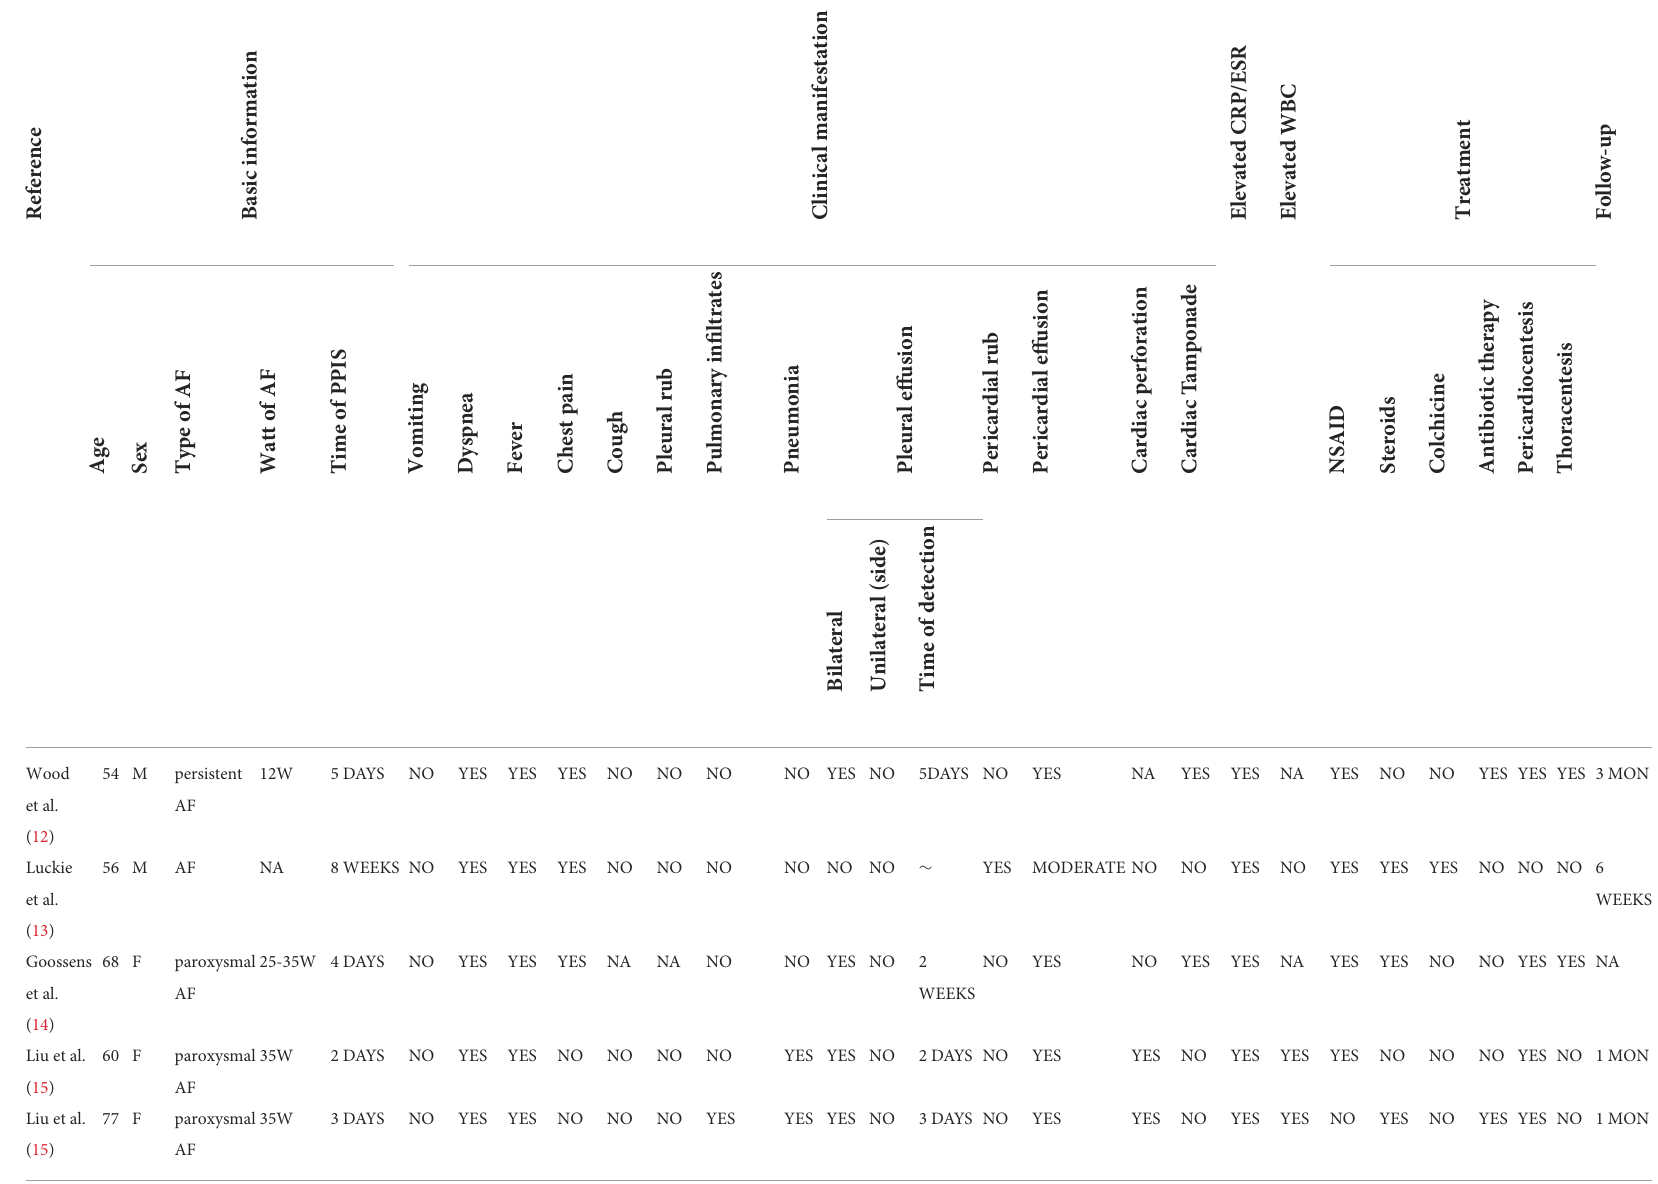
TABLE 2 Clinical characteristics of all cases reported in the